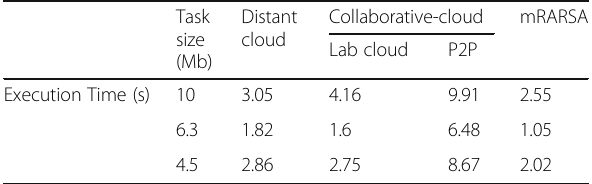
Table 10 Network latency performance evaluation for Eight- Queen problem Table 11 Execution time performance